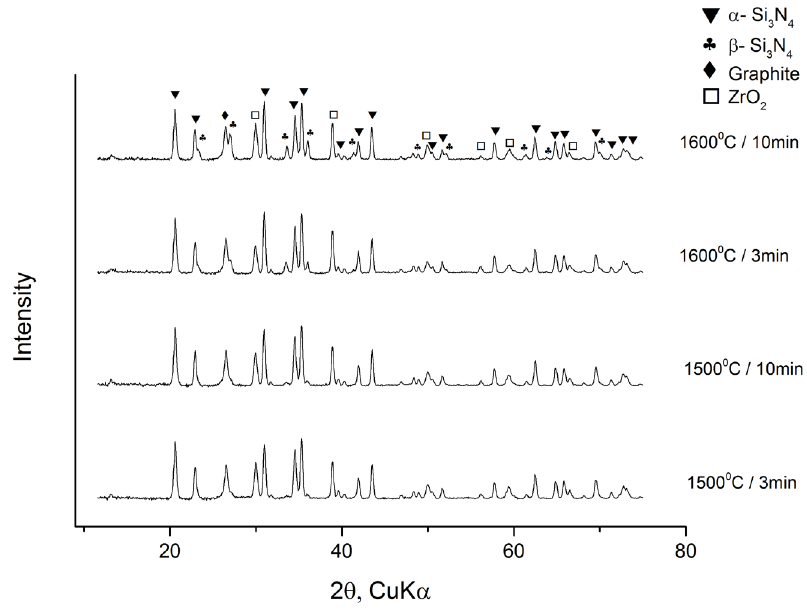
N composites are 3 4